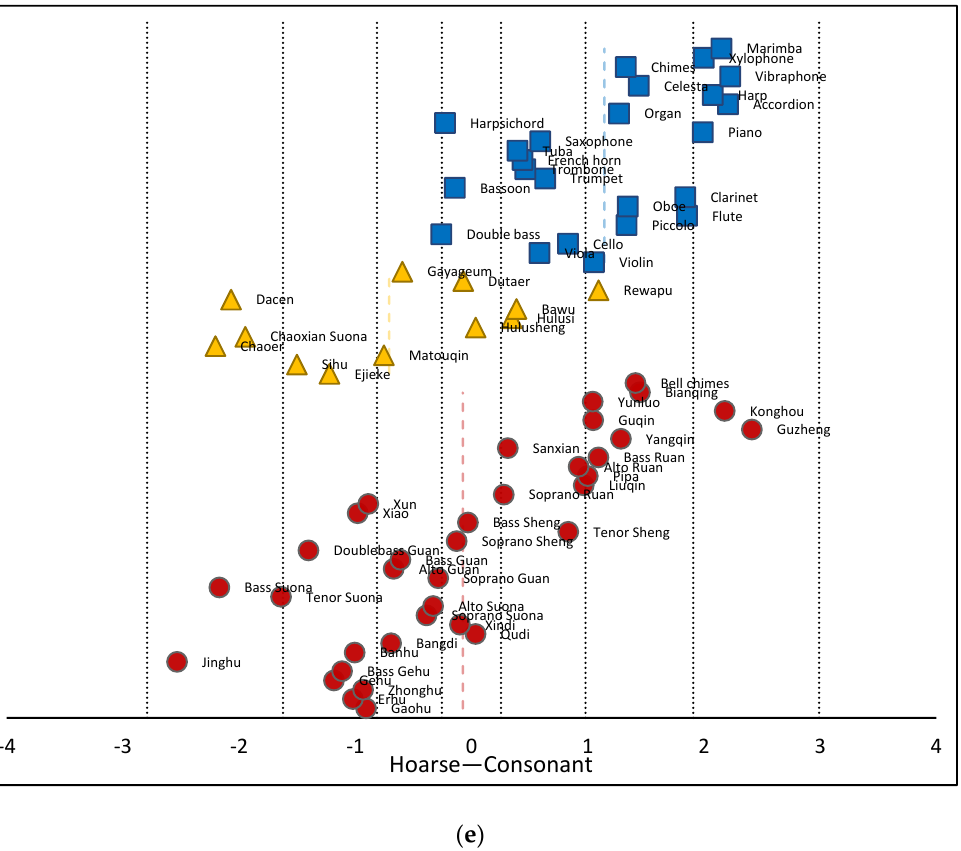
Figure 4. A psychological scale of 72 musical instruments, including ( a ) bright / dark, ( b ) raspy / mellow, ( c ) sharp / vigorous, ( d ) coarse / pure, and ( e ) hoarse / consonant. The blue squares represent Western orchestral instruments, the yellow triangles represent Chinese minority instruments, and the red circles represent Chinese orchestral instruments. The dotted blue line represents the mean value of the Western orchestral instruments, the dotted yellow line represents the mean value of the Chinese minority instruments, and the dotted red line represents the mean value of the Chinese orchestral